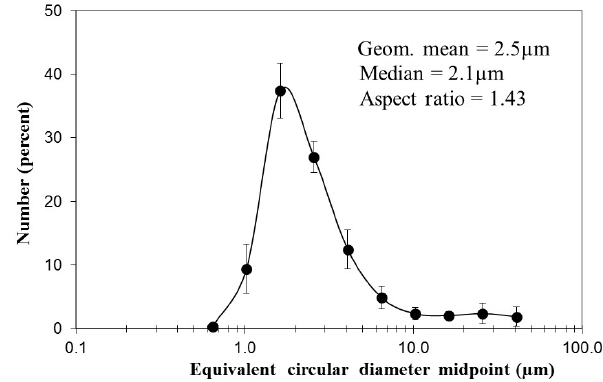
Figure 7. Average and standard deviations of particle sizes, as well as size and shape statistics for 13 sieved samples < 38µm as mea- sured by